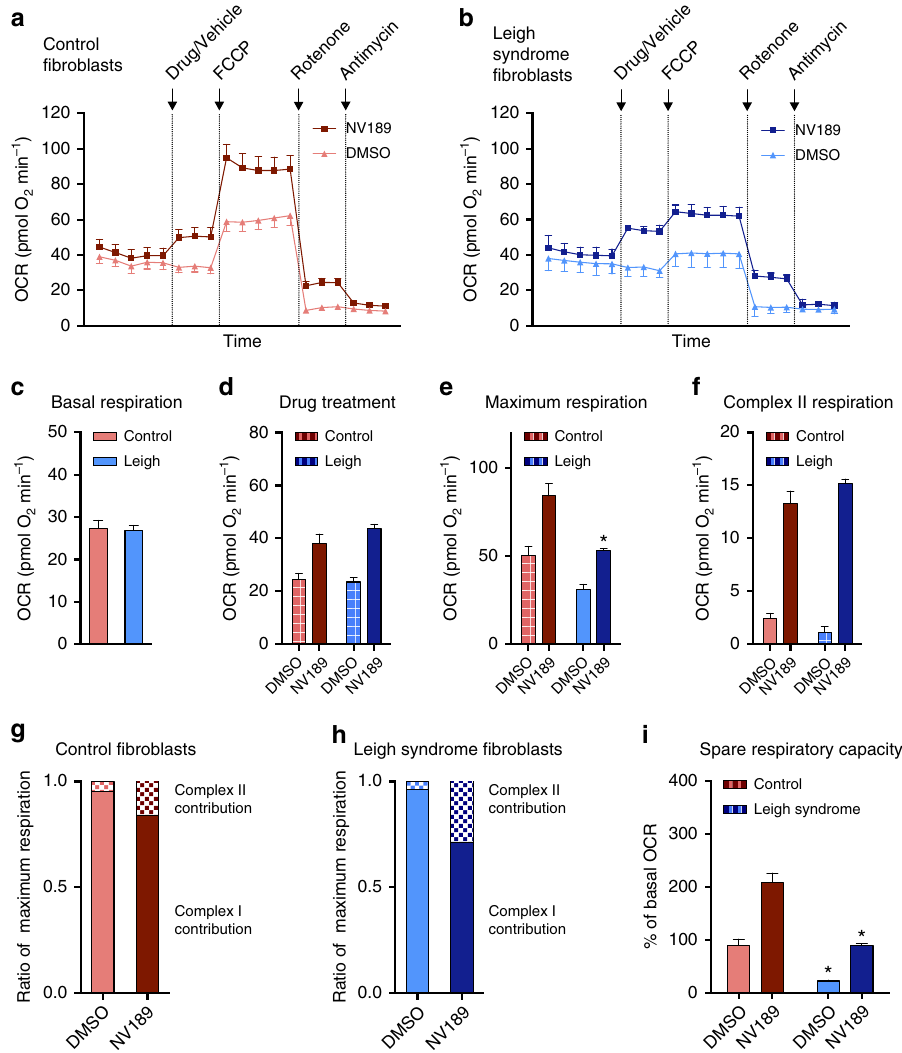
Figure 3 | Succinate prodrug treatment of mitochondrial complex I-deficient Leigh syndrome patient fibroblasts. ( a , b ) Oxygen consumption rate (OCR) in three control fibroblast cell lines and a mitochondrial complex I-deficient cell line (recessive NDUFS2 mutation) treated with NV189 or vehicle. ( c – f ) Quantification of OCR in control and patient fibroblasts for each respiratory state. ( g , h ) Relative contribution of complex I- and complex II-linked respiration to maximum uncoupled respiration in patient cells and control cell lines. ( i ) Spare respiratory capacity, defined as per cent increase from endogenous baseline to maximum uncoupled respiration. Data presented as mean and s.e. of n ¼ 3 experiments from separate cell culture flasks performed with eight technical replicates each time for each cell lines. Data from the three control cell lines are pooled. * P o 0.05 (two-tailed unpaired Student’s t -test, difference between Leigh and control cell